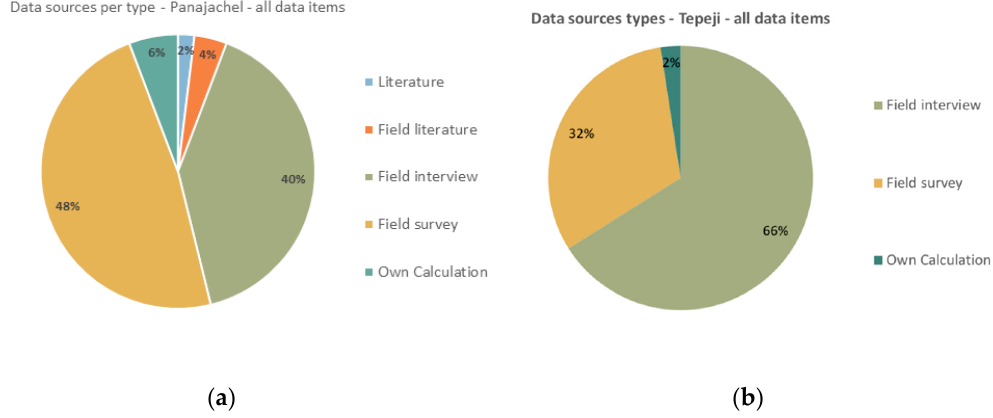
( a ) ( b ) Figure 4. Data sources per type. ( a ) Panajachel pilot site; ( b ) Tepeji pilot site.